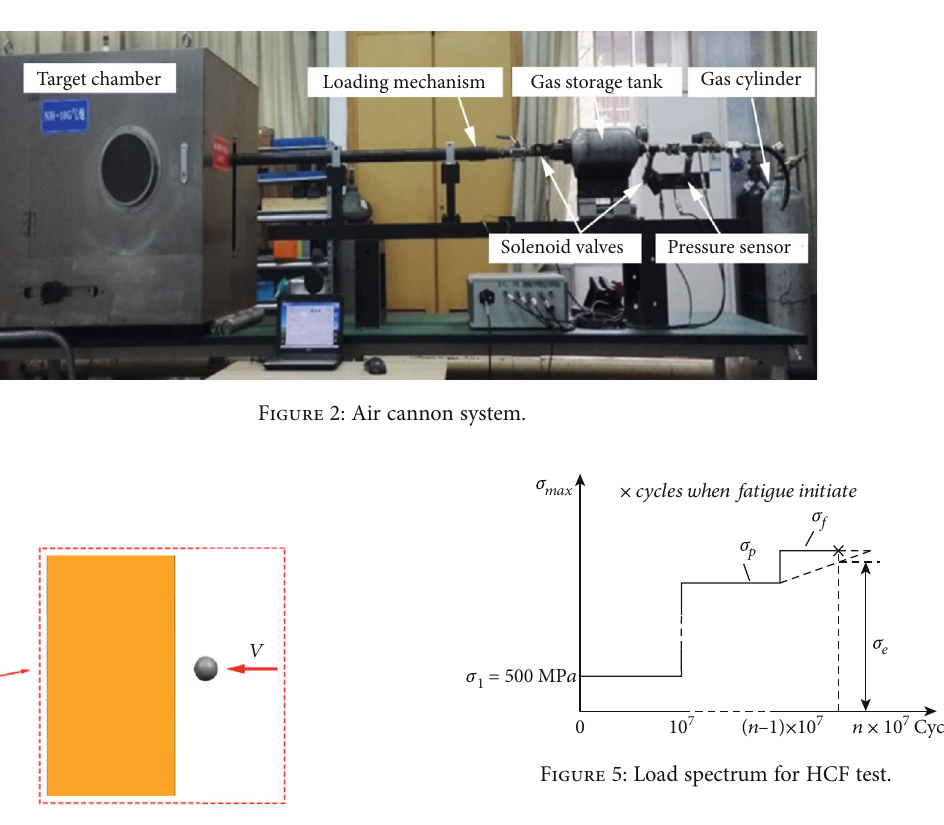
Figure 1: Size of fl at plate specimen.